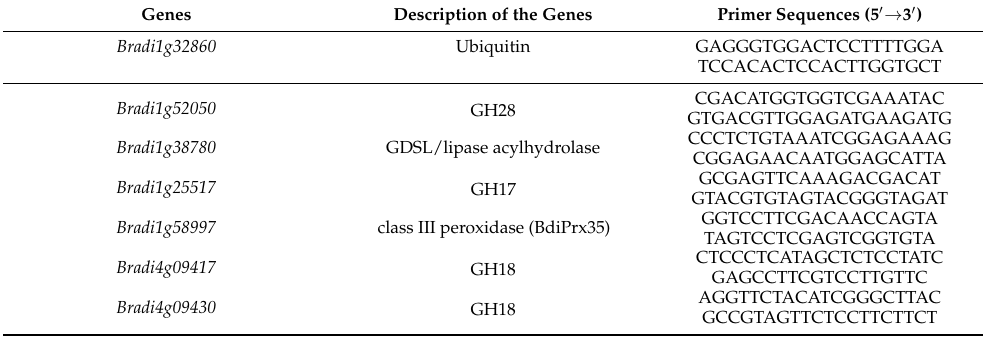
Figure A1. The 1D-electrophoretic patterns of the proteins that were isolated from the purified cell walls of the B. distachyon leaves that had been treated at 40 ◦ C and the control. Sixty µ g of the proteins were analysed for each sample. After electrophoresis, the proteins were stained with Coomassie blue. Some of the bands of similar intensity across all treatments are marked with arrows. The bands differentiating plants treated at 40 ◦ C from those at the control are marked with asterisks. Table A1. The oligonucleotide primers that were used for the RT-qPCR analysis with the relevant descriptions of the